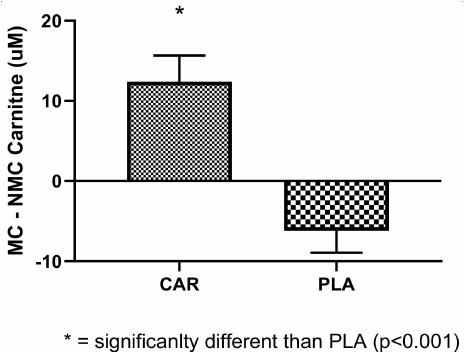
Figure 11. Changes in serum carnitine levels during the menstruation cycle from pre-menstruation are shown. * indicates statistical significance between groups ( p < 0.001). The groups are carnitine (CAR) and placebo (PLA). Abbreviations: MC = menstrual cycle; NMC = non-menstrual